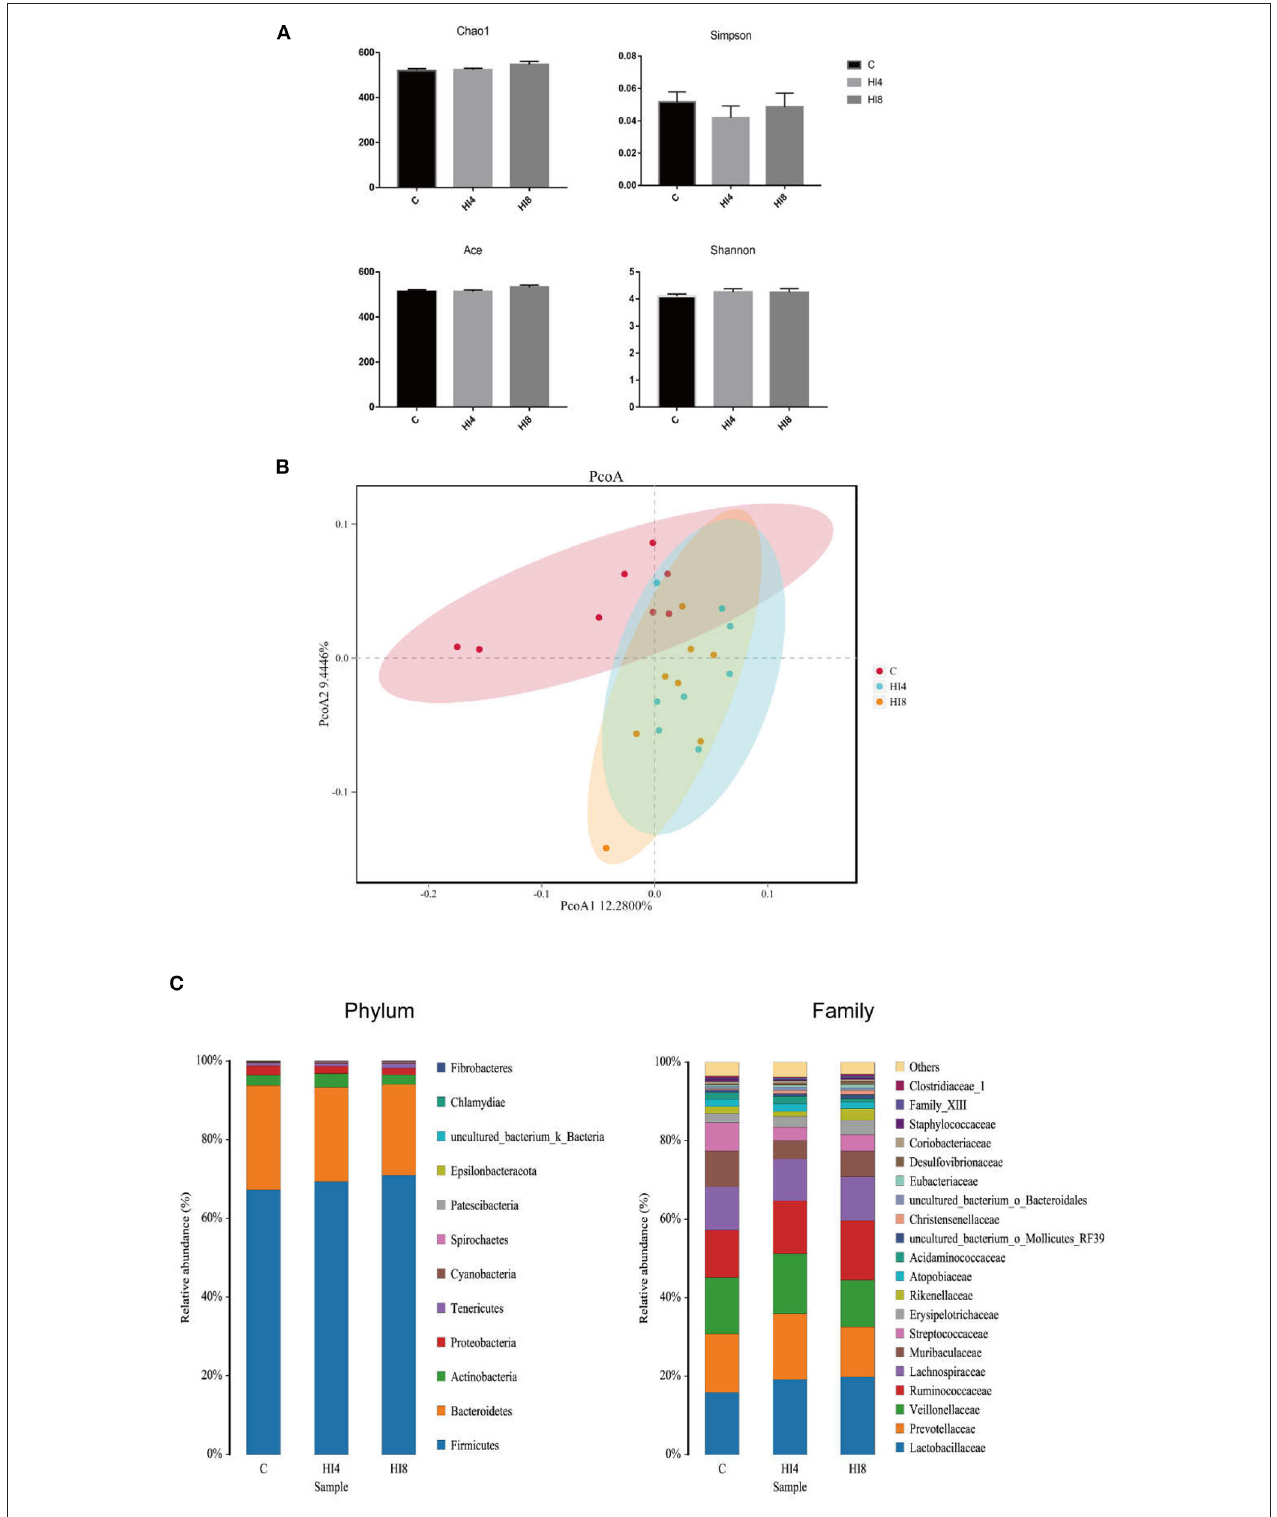
FIGURE 1 | Richness and diversity of fecal. (A) Chao1 index, Simpson index, Ace, Shannon. The values are means ± SEM ( n = 8). (B) Principal coordinates analysis (PcoA) of bacterial communities in the fecal of pigs (based on the Binary-Jaccard). ( n = 8). (C) Phylum-level and Family-level relative abundance of 16S rRNA gene sequences from the fecal of pigs ( n = 8). The figure provided is an average of the three analyses.